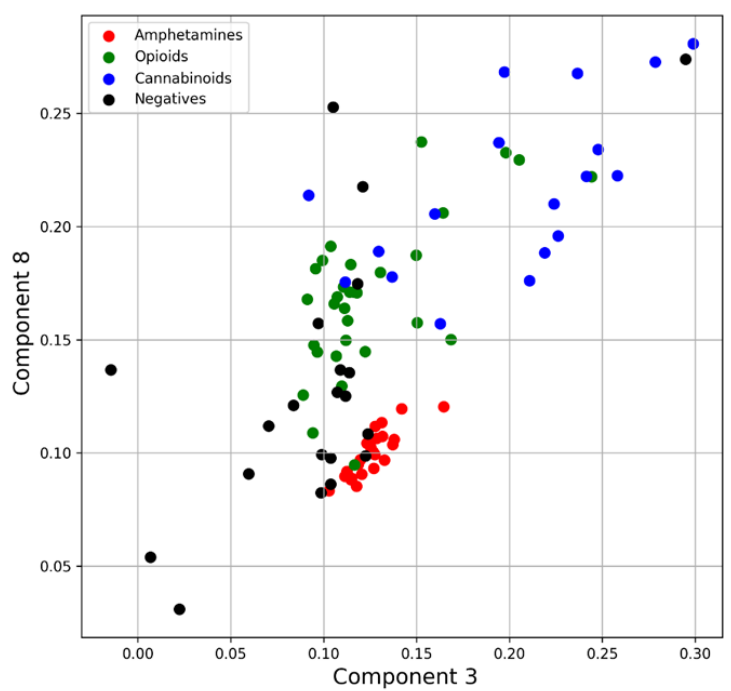
Figure 4. Score plot of the 3rd and 8th components of a ten-component transformed operation dis- playing the class of amphetamines (red), opioids (green), cannabinoids (blue), and negatives (black).